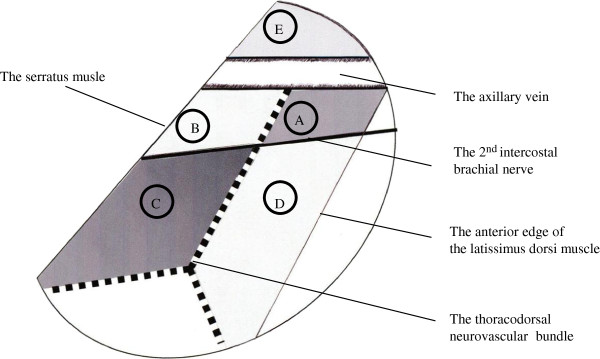
Mapping of the ARM lymph nodes in the axilla. Field A is the area between the axillary vein and the second intercostobrachial nerve and between the anterior edge of the latissimus dorsi muscle and the thoracodorsal neurovascular bundle. Field B is the area medially adjacent to field A and close to the anterior serratus muscle (the chest wall). Field C is the area surrounding the second intercostobrachial nerve, the anterior serratus muscle, and the thoracodorsal neurovascular bundle. Field D is the area below field A and laterally adjacent to field C. Field E is the area above the axillary vein.